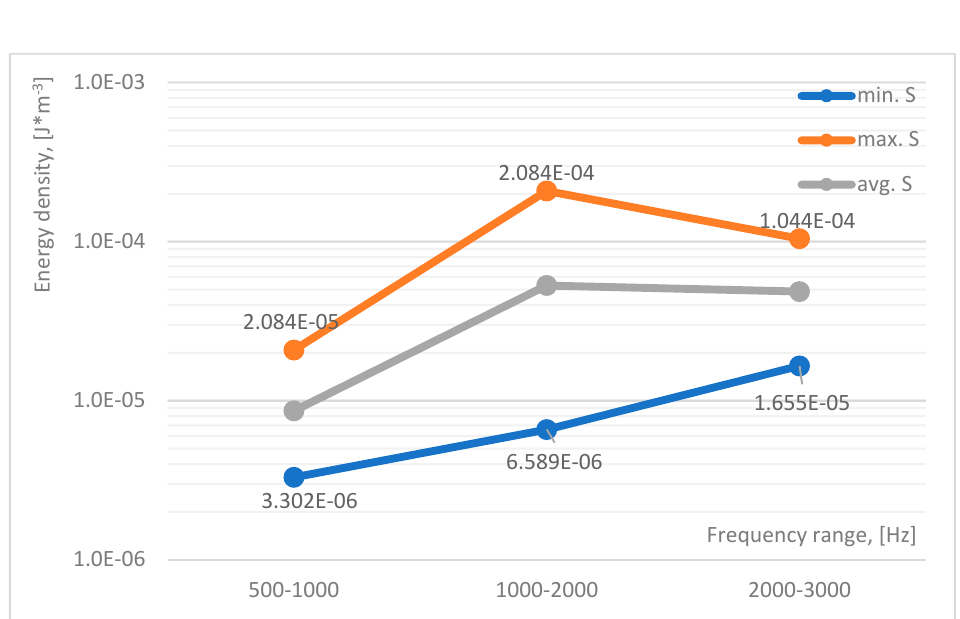
Figure 16. The average value of the total acoustic wave energy density for a straight track, at a speed of 200 km/h.